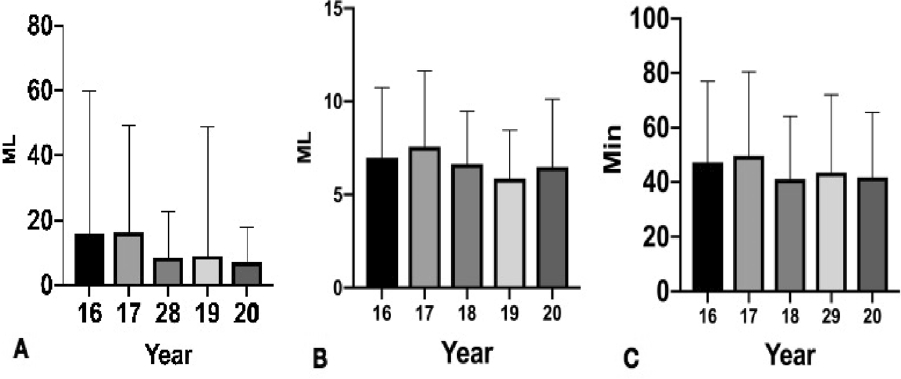
Figure 2. ( A ) Surgery bleeding, ( B ) cement volume and ( C ) surgery time.